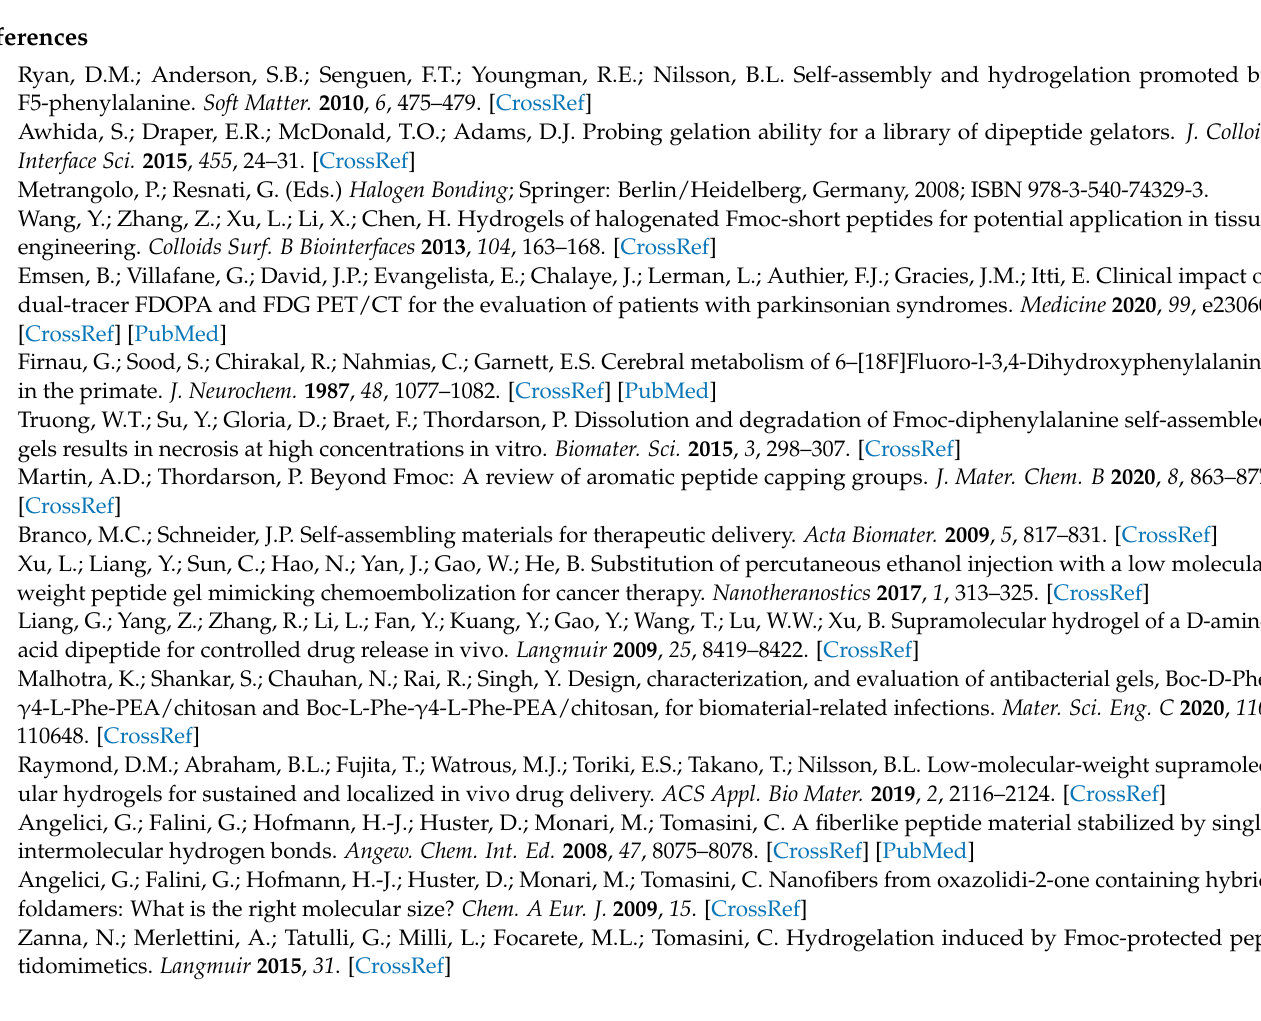
obtained with an optic microscope with a 10x magnification. Figure S4. Hydrogel images of 7 , 8 and 9 obtained with an optic microscope with a 40x magnification. Figure S5. DLS correlation coefficient, number and volume analysis of particles after filtration: (a) solution 4 ; (b) solution 5 ; (c) solution 6 . Figure S6. Amplitude sweep analysis of hydrogel 1 . Figure S7. Amplitude sweep analysis of hydrogel 2 . Figure S8. Amplitude sweep analysis of hydrogel 3 . Figure S9. HPLC-MS analysis of gelators B and C before and after the addition of GdL. Figure S10. Time sweep analysis of hydrogel 10 . Figure S11. Absorbance spectrum of hydrogel 10 . Figure S12: 19F-NMR spectra registered in D2O of gelators A and C before and after the gelation